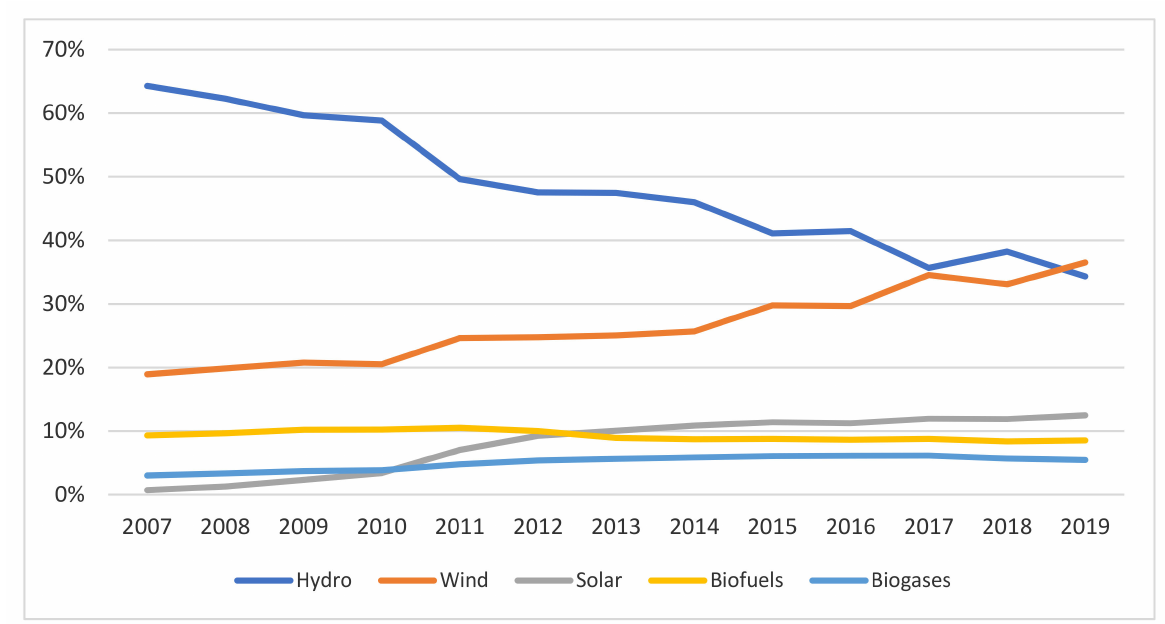
Figure 2. Shares of selected renewable sources ( X EU Source: Own calculation based on Reference